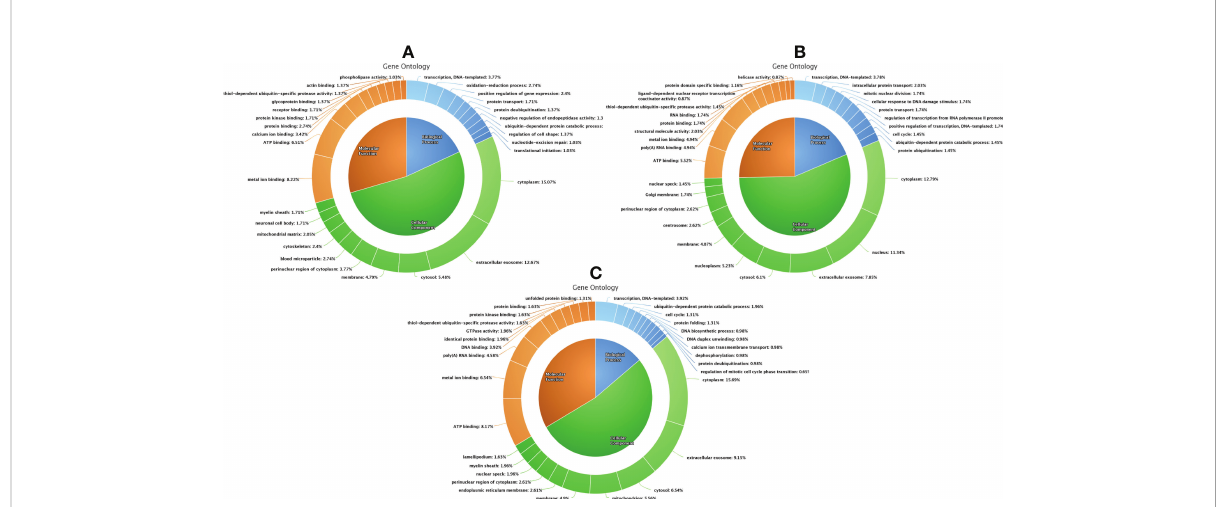
TABLE 1 Top 10 dysregulated pathways between fresh and equilibrated spermatozoa and the associated proteins. Pathways Protein count